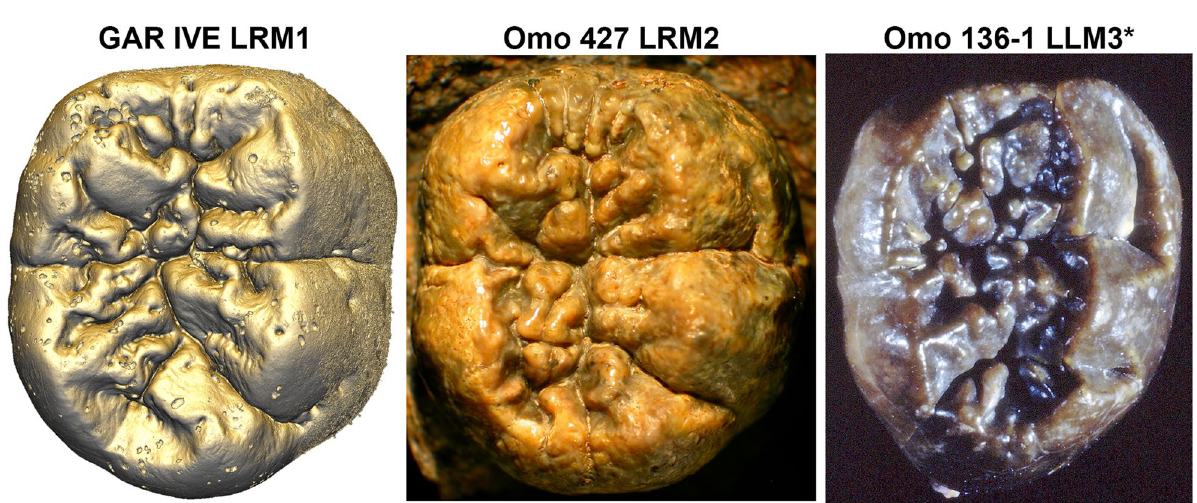
Figure 3. The occlusal surface of the LRM1 of GAR IVE (3D model) shows an amount of wrinkling comparable with that of other Plio-Pleistocene hominin molars such as the LRM2 of Omo 427 and the LLM3 of Omo 136-1 (*: flipped for illustrative purpose; both teeth were